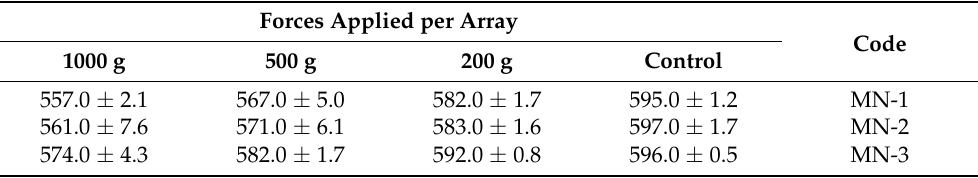
Table 7. The reduction in height ( µ m) of MN-1, MN-2, and MN-3, tested as a function of forces of 200, 500, and 1000 g per array (Mean ± SD, n = 3).